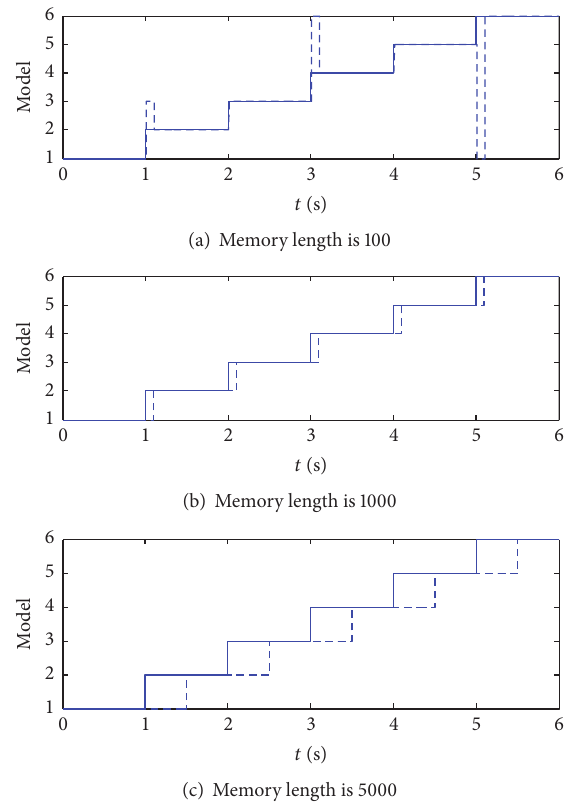
Figure 8: Model switching with different memory length.